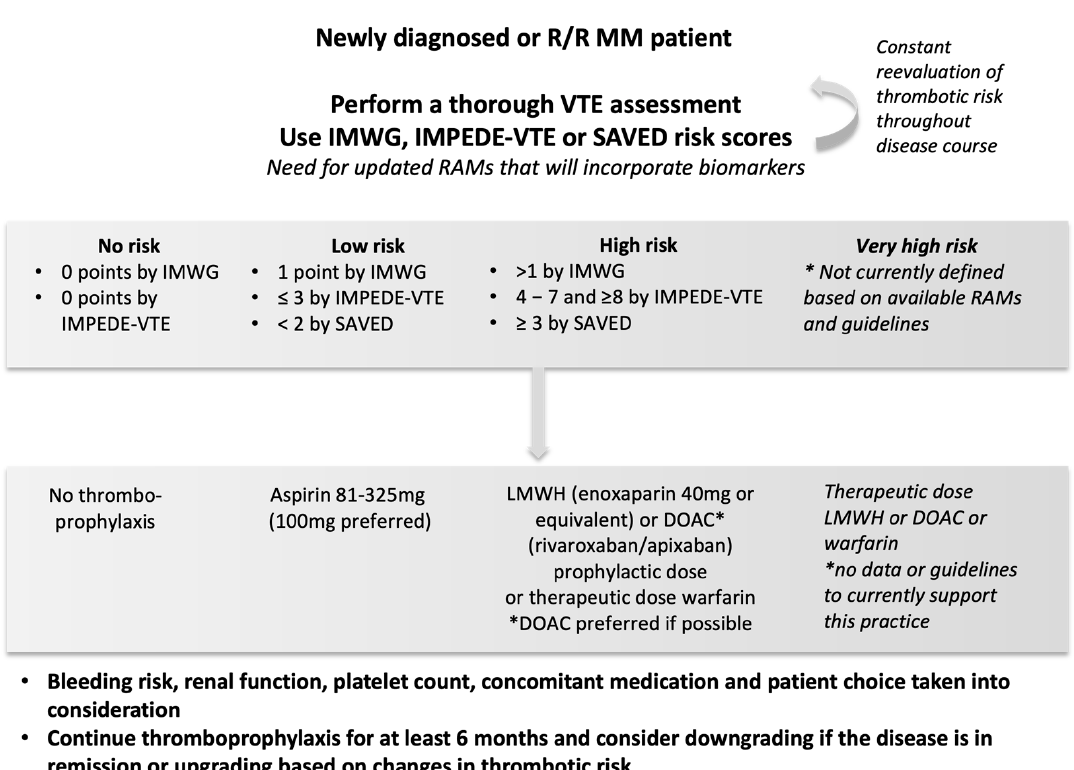
Figure 2. Algorithm for the assessment of VTE risk and choice of thromboprophylaxis. R/R: re- lapsed/refractory, MM: multiple myeloma, IMWG: international myeloma working group risk score, RAMs: risk assessment models, LWMH: low-molecular-weight heparin, DOAC: direct oral anticoagulant. * DOAC preferred if possible